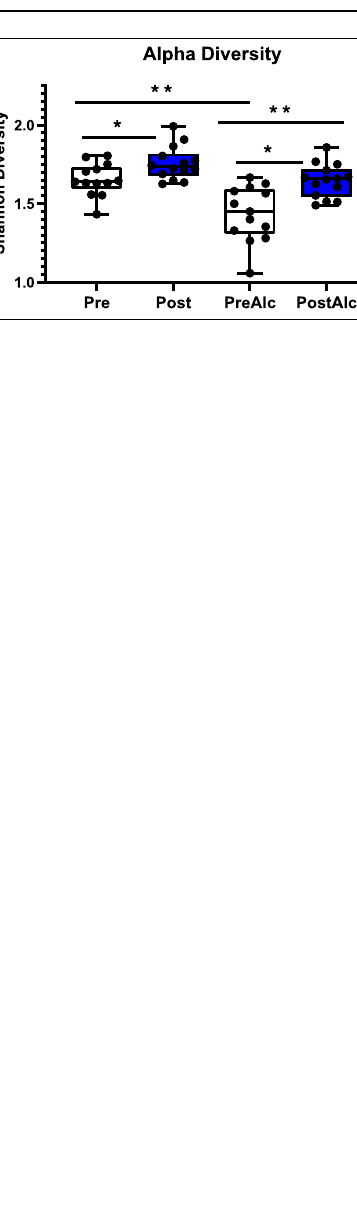
average relative abundance from human donors pre and post to GF mice. DonorPre:combinedstoolsfrompatientswithcirrhosiswhowereactivelydrinking that were collected before the FMT from a healthy human, DonorPost combined stoolsfromthesamepatientswithcirrhosisinDonorPrecollected15daysafterthe FMT from a healthy human, Pre-FMT stools from germ-free mice colonized with stools from DonorPre, Post-FMT stools from germ-free mice colonized with stools from DonorPost. Higher relative abundance of several genera belonging to Rumi- nococcaceae and Lachnospiraceae in DonorPost vs DonorPre, which was re fl ected in their respective mouse